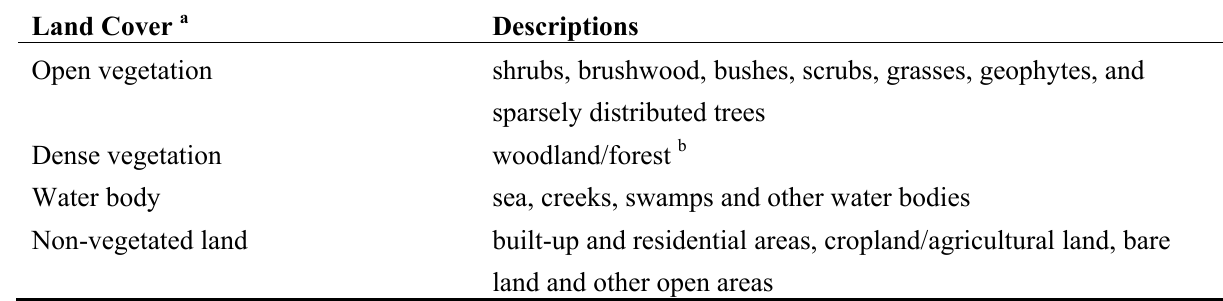
Table 2. Land cover classification scheme for the City of San Fernando.